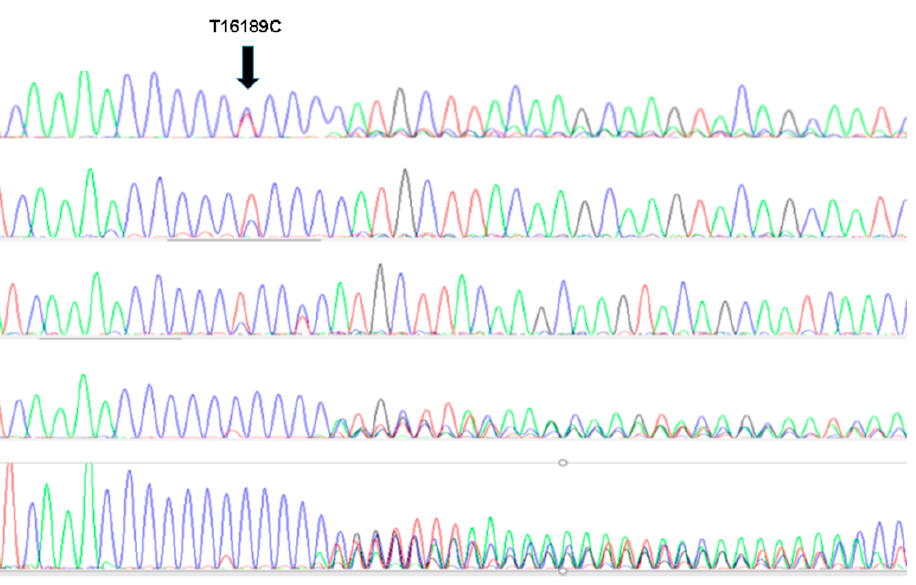
Figure 1. Mitochondrial DNA (mtDNA) sanger analysis. PCR fragments were sequenced to deter- mine the degree of lenght heteroplasmy. The presence of a T interrupting the polyC was found in either homoplasmic or single nucleotide T/C heteroplasmics (three upper lines) while the absence of low T signal was found among individuals with complete lenght